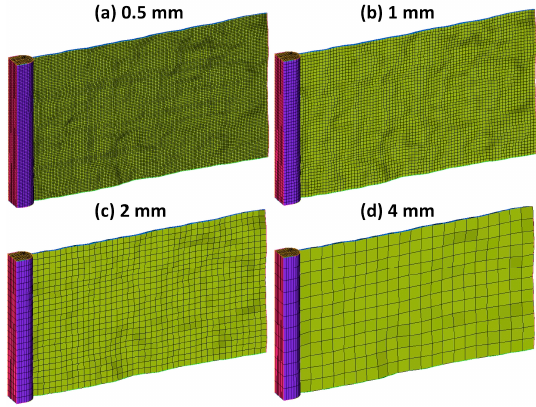
Figure 6. Numerical model at different mesh size.